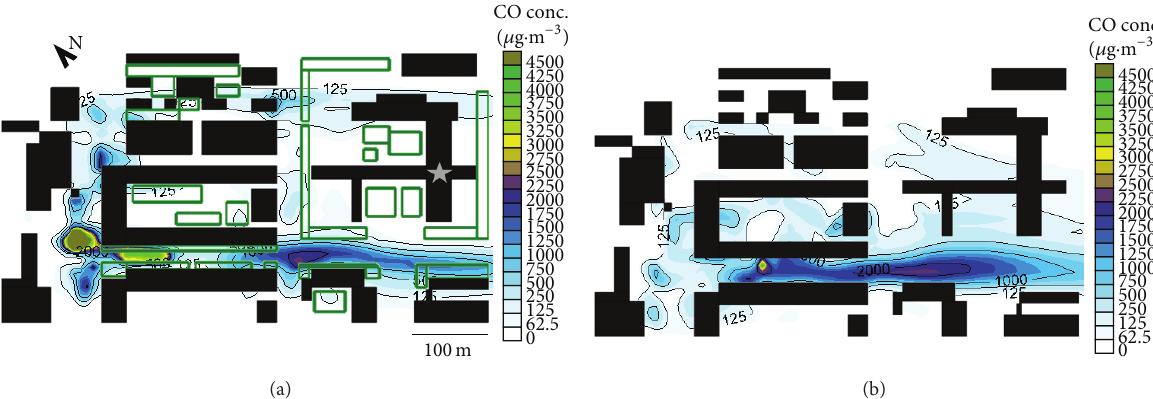
Figure 4: Comparison of 3 m high horizontal CO concentration fields with (a) and without (b) the effect of trees (in green) for the period between 8 and 9a.m. The star indicates the location of the